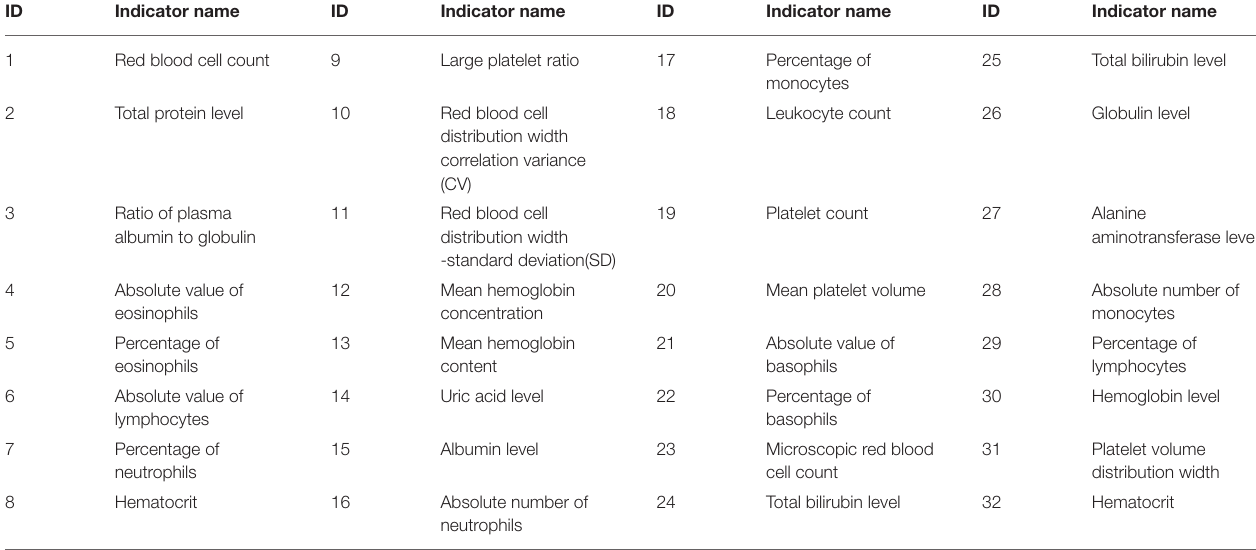
TABLE 1 | Types of medical markers included in the study.